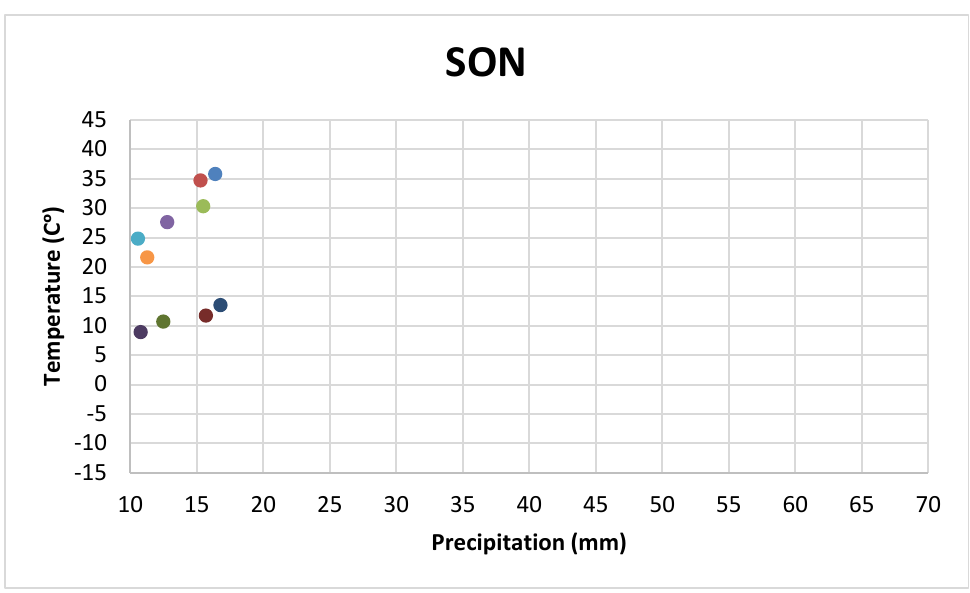
Figure 3. Distribution of bioclimatic zones against seasonal temperature and precipitation conditions in the study